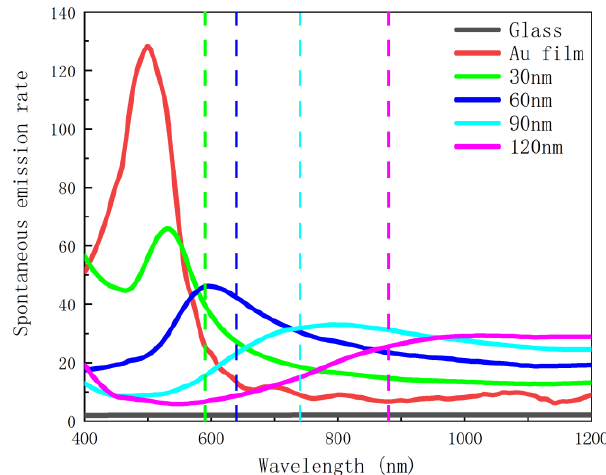
Figure 5. Enhanced spontaneous emission with different hemisphere radii (the dashed lines represent the peak wavelengths of the scattering cross-section).